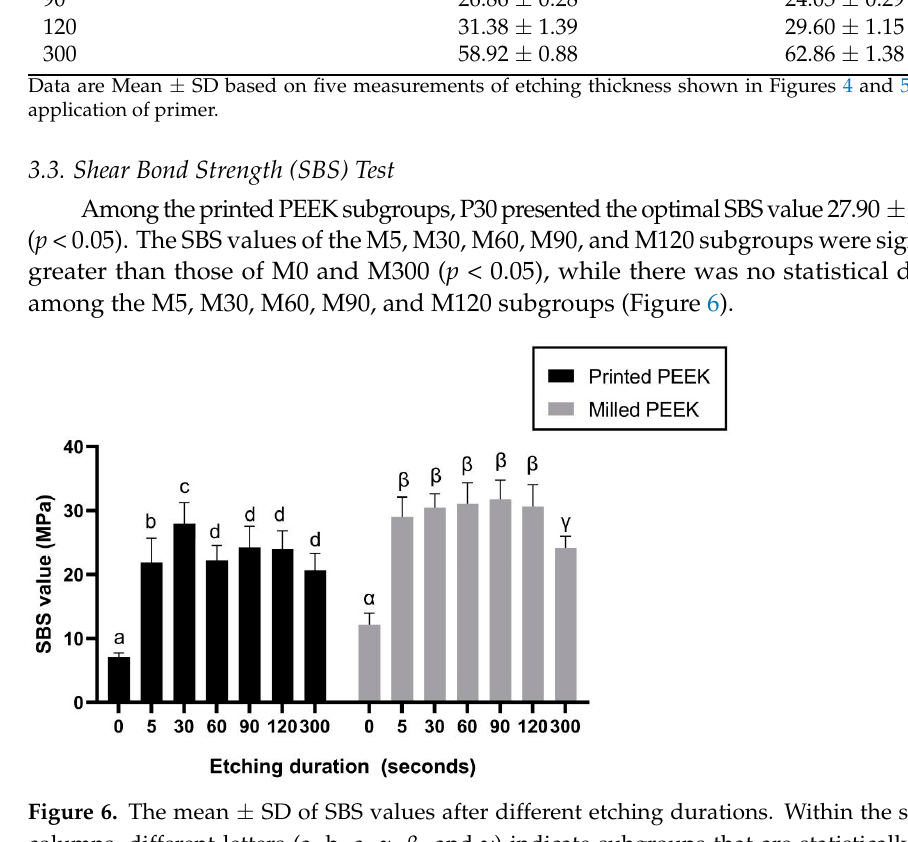
Table 4. Failure modes of each testing group after different surface treatments. Etching Dura- tion (Seconds)